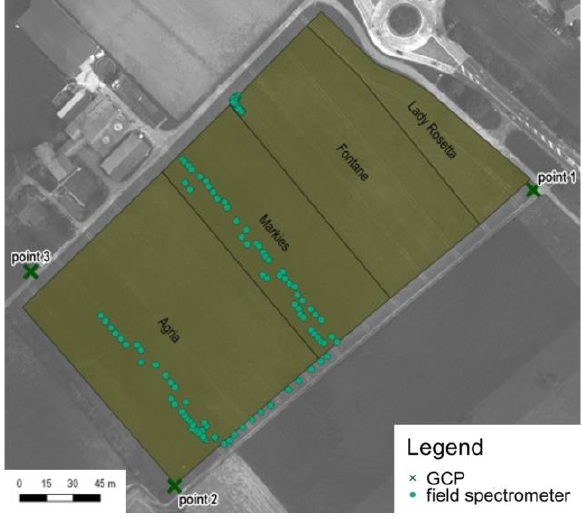
Figure 6. Potato field (31.07.14) with field spectrometer measurements (green dots) and GCP positions (green crosses).